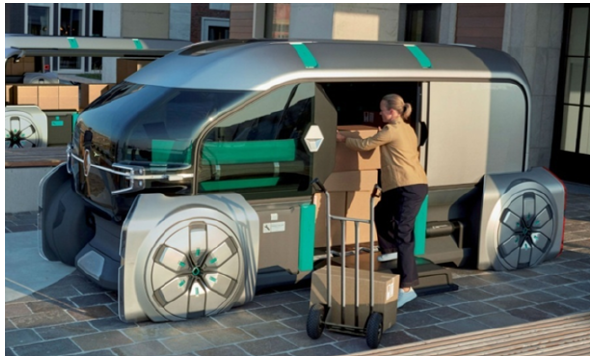
Figure 1: EZO-Pro autonomous delivery vehicle [21].